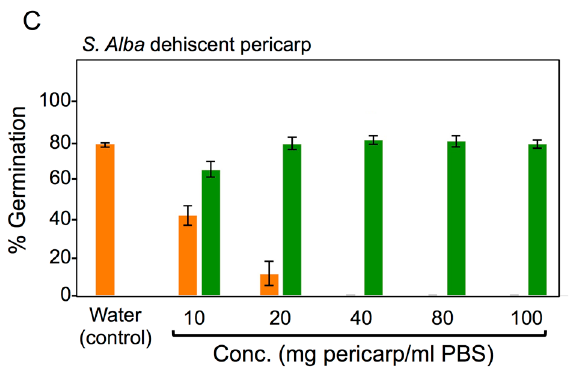
Figure 6. Dehiscent and indehiscent pericarps of S. alba contain germination inhibitory substances-Lab experiments. ( A ) Germination test of S. alba seeds incubated in distilled water or in S. alba indehiscent pericarp extract. Note that there is complete inhibition in the presence of indehiscent pericarp extract. Seeds of S. alba were incubated in distilled water and different concentrations (10, 20, 40, 80, 100 mg pericarp/mL of distilled water) of indehiscent ( B ) and dehiscent ( C ) S. alba pericarp extracts. After 56 h, the seeds treated with pericarp extracts were washed thoroughly with water and seeds were incubated in water for assessment of germination recovery. Note, seed germination was reduced significantly in the presence of pericarp extracts (orange column) but fully recovered after removal of extracts and incubation in water (green column). Data are the mean of three replicates (±SE).